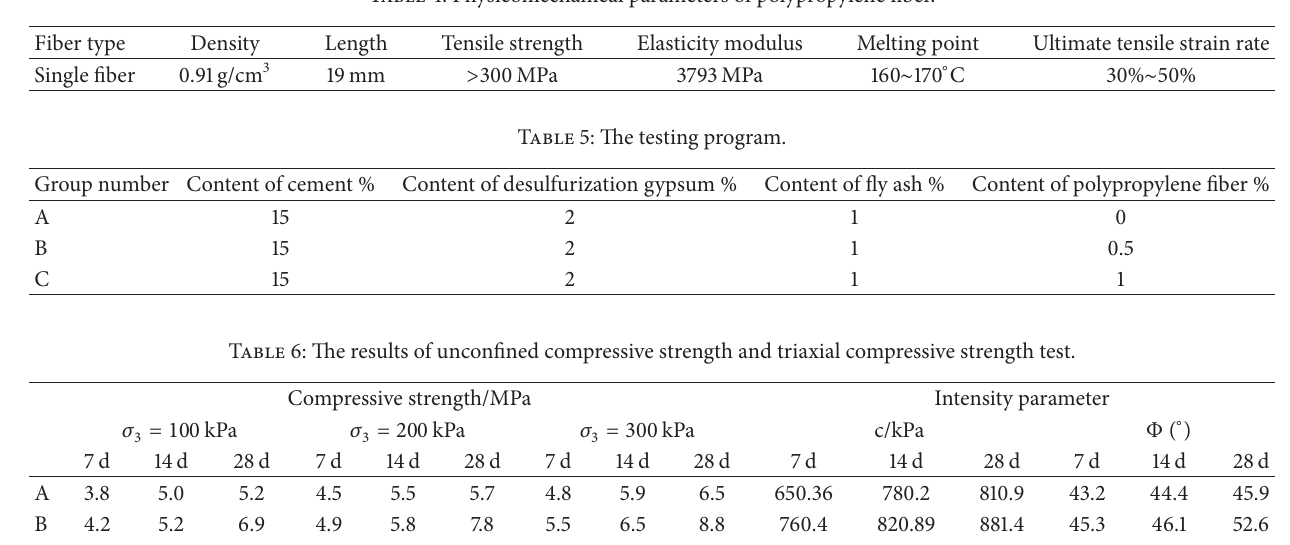
Table 4: Physicomechanical parameters of polypropylene fiber.